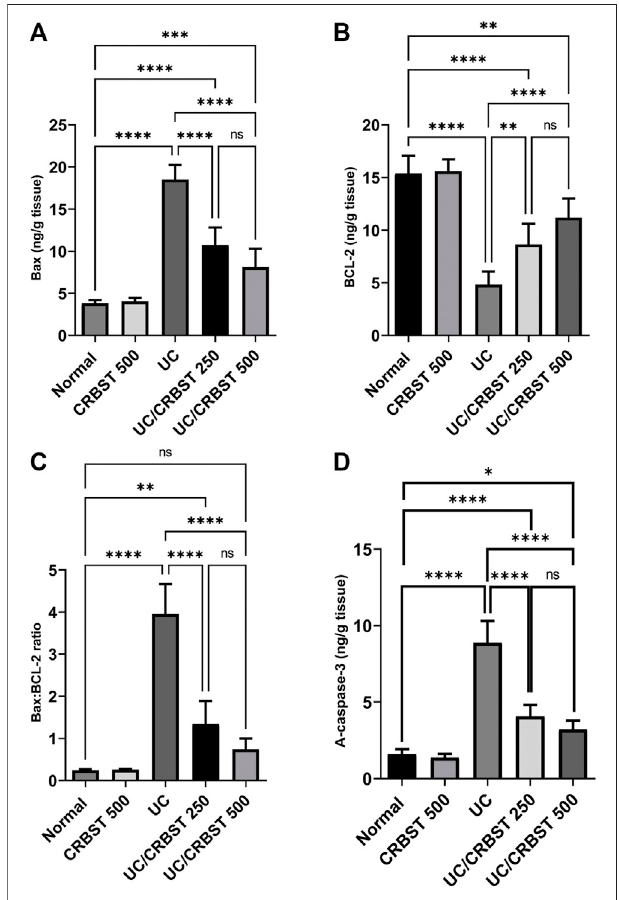
FIGURE4| Effect ofCRBST 250and 500 mg/kgonIL-6 (A) ;TNF- α (B) ; TLR4 (C) and IL-10 (D) in rats with AA-induced UC. Results are shown as the mean±SD(n=6). * p < 0.05,** p < 0.01, *** p < 0.001,**** p < 0.0001.Normal, normal control rats administered the vehicle; CRBST 500, normal rats administered carbocisteine (500 mg/kg); UC, AA-induced UC rats administered the vehicle; UC/CRBST 250, AA-induced UC rats treated with carbocisteine (250 mg/kg);UC/CRBST500,AA-induced UCratstreated with carbocisteine (500 mg/kg).